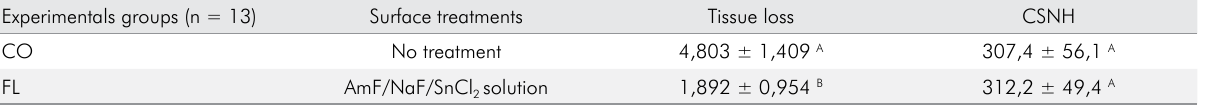
Table 1. Results (mean ± SD) of tukey test (p < 0.05) with dependent variables cross-sectional nanohardness (CSNH) and tissue loss (µm) for the study groups after in situ erosive challenging. Experimentals groups (n =